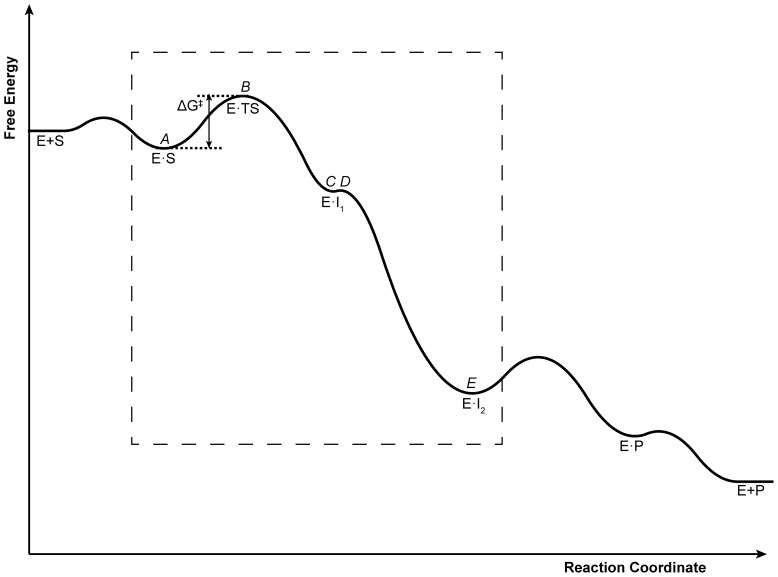
Qualitative GUS free energy diagram based upon in vacuo QM calculations.The free energy of each intermediate within the dashed box is based on its potential energy, as calculated using QM. Intermediates found using QM and proposed TSs are also labeled according to Figure 4 (italicized, above curve). The energy barrier between states C and D is nearly barrier-less. The free energy values along the remainder of the curve are purely hypothetical. Each intermediate is labeled according to the convention used in Equation 3. Based on the known and hypothesized free energies, the reaction of the Michaelis complex to form the first intermediate (k2, as written in Equation 3) is rate-limiting. Thus, the proposed TS for the entire reaction (E·TS) and its corresponding energy barrier (ΔG‡) are labeled.